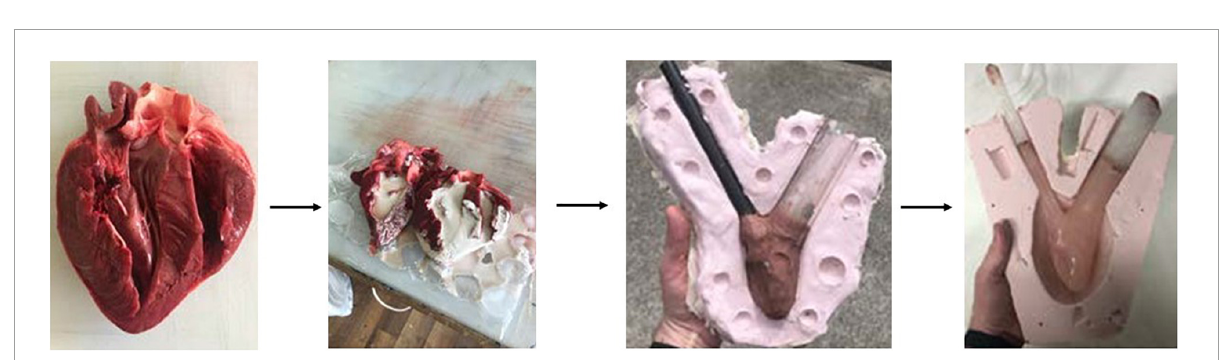
FIGURE2 The internal volume of the left ventricle was cast using room-temperature vulcanizing silicone. Chavant clay was used with attached tubing to form the core for the reverse molding of the RTV silicone. The silicone outer mold was then used to rapidly produce multiple cores made of paraffin wax. Finally, the final chamber model was produced by pouring Platsil Gel 10 silicone into the interstitial space between the larger mold and the wax